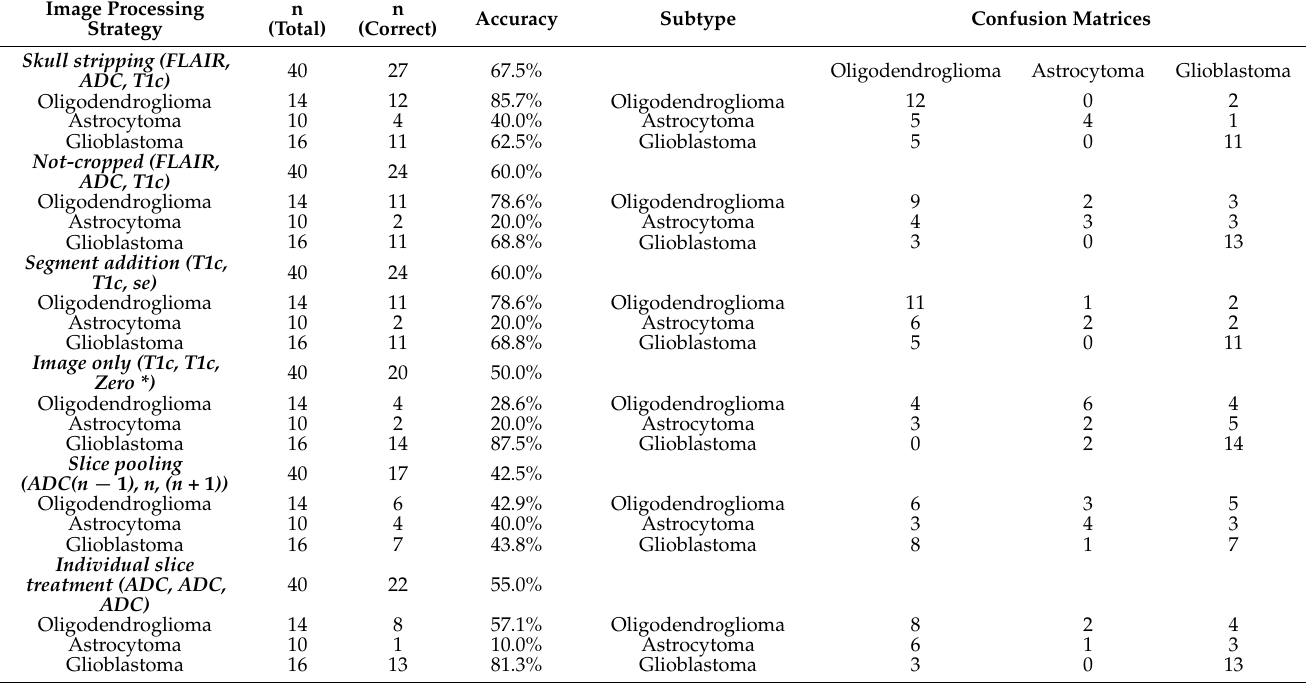
Table 4. Summary of classification results for different slice preprocessing strategies on test